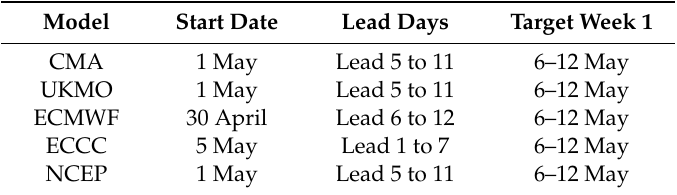
Table 2. Example of constructing a multi-model ensemble (MME) with the first start date. Model Start Date Lead Days Target Week 1 CMA 1 May Lead 5 to 11